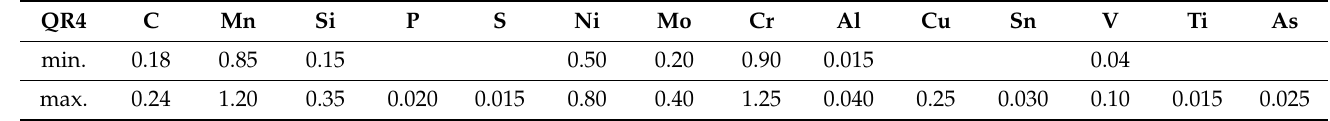
Table 1. Nominal composition of the grade R4 steel in wt.% (the rest is